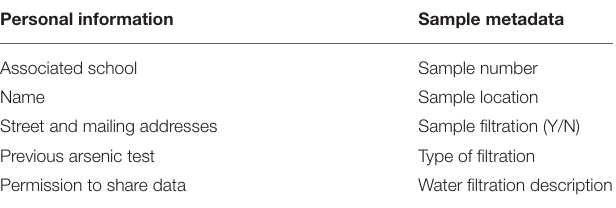
TABLE 2 | Metadata in “All About Arsenic”